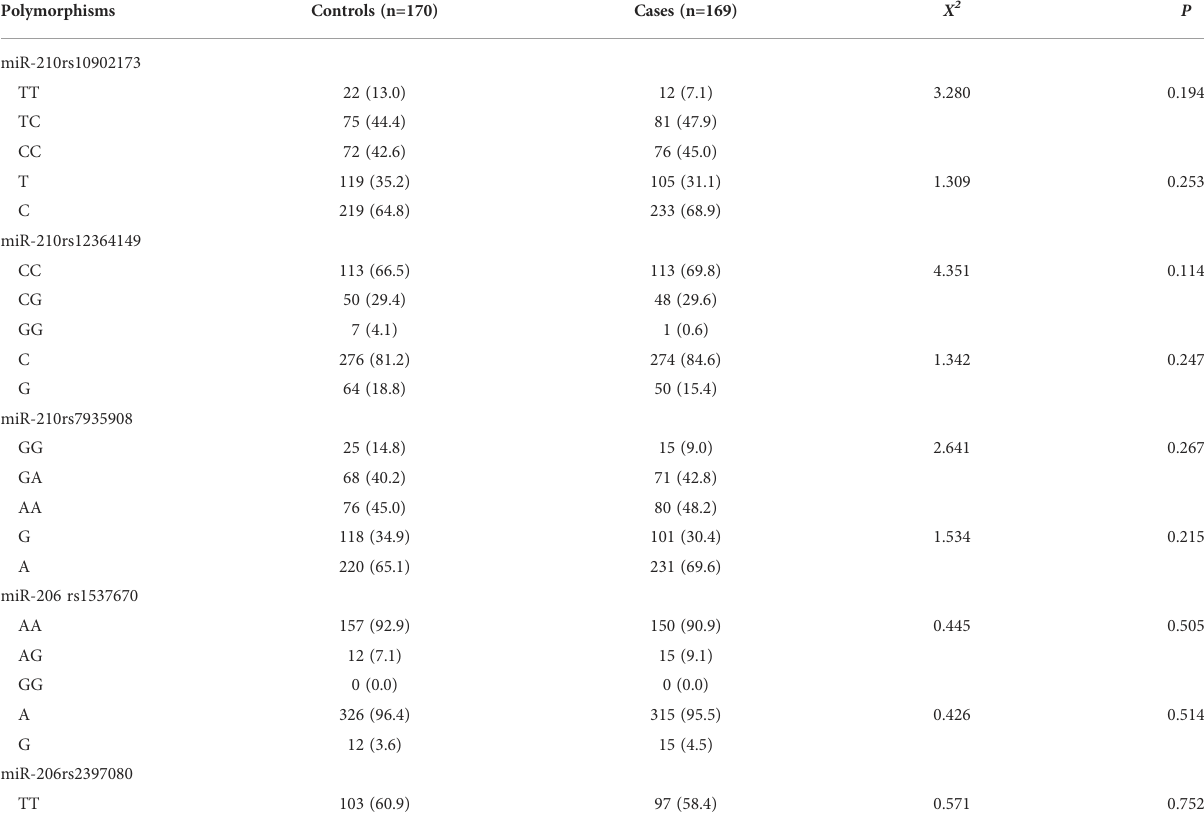
TABLE 4 The distribution of miRNA genetic polymorphism between the control group and the case group.